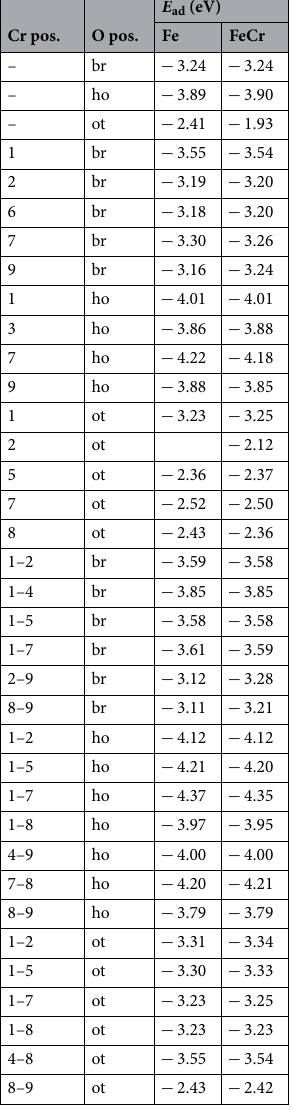
Table 2. Adsorption energies (in eV) of an oxygen atom calculated using the lattice constant of pure iron (‘Fe’) and the lattice constant of Fe 0.91 Cr 0.09 (‘FeCr’). For instance, the notation ‘1–2 br’ means that there are Cr atoms at sites 1 and 2 (see Fig. 1 for the site numbering) and that the oxygen atom is adsorbed at the bridge position. The sites have the following labels: ‘br’ is the bridge site, ‘ot’ is the on-top site, and ‘ho’ is the hollow